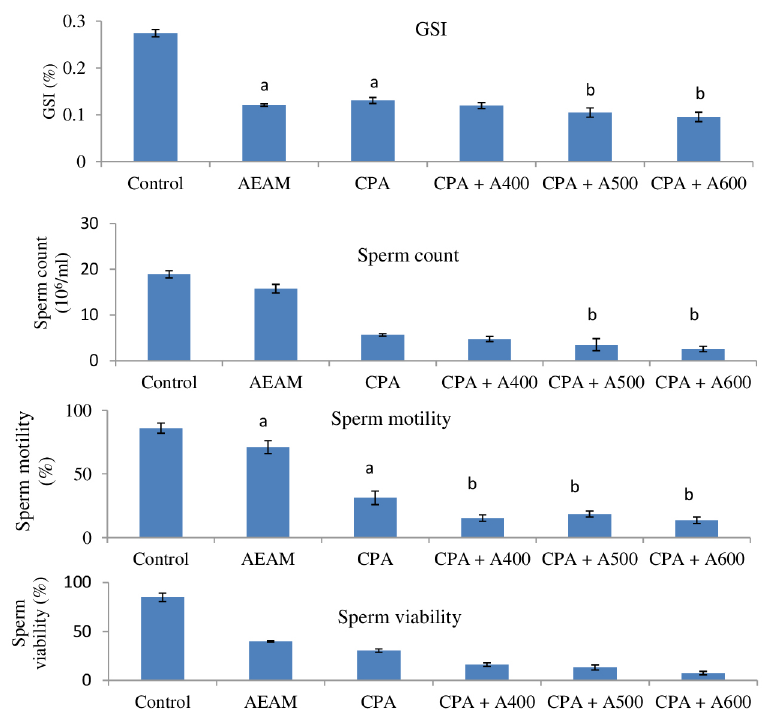
FIGURE 1 - Effect of aqueous extract of A. marmelos on CPA-induced toxicity on GSI, Sperm count, Sperm motility and Sperm viability. Each bar represents the Mean ±SE, n=6; ‘a’ indicates the significant difference between the control and CPA treated groups, ‘b’ indicates the significant difference between the CPA treated and AEAM treated groups. Significant at p <0.001.